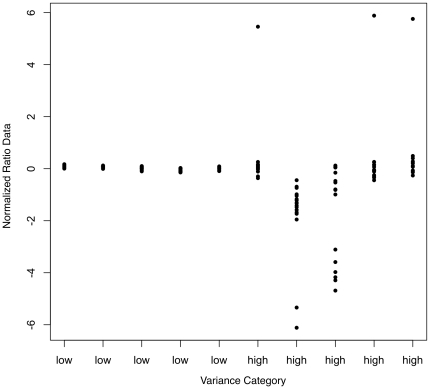
Examples of data from low- and high-variance probes.Normalized log(2) ratio data for 5 probes of low variance and 5 probes of high variance across multiple experiments. High-variance probes are likely to have outlier values for one or more experiments, but also have large variance even when outliers are excluded.